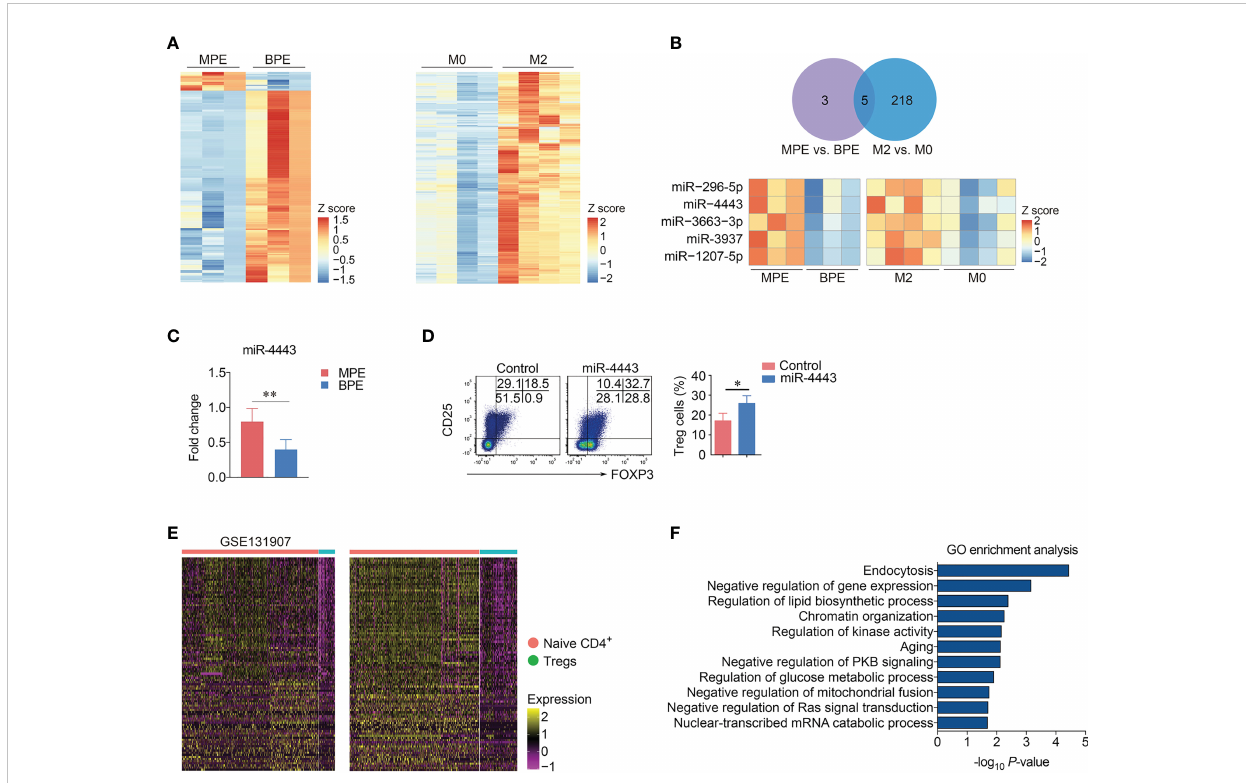
FIGURE 5 miR-4443 induced the differentiation of Treg cells. (A) Heatmaps showed the miRNA expression pro fi le of the exosomes from M j s in MPE and benign pleural effusion (BPE) (each n = 3) (left panel) or in M0 and M2 M j s downloaded from GSE97467. (B) miR-296-5p, miR-4443, miR-3663-3p, miR-3937 and miR-1207-5p were up-regulation in both two data sets. (C) Expression of miR-4443 in the exosomes from MPE and BPE detected by RT-qPCR (each n = 8). Data are presented as mean ± SEM. Comparisons were made using Student ’ s t test. ** P < 0.01, NS, not signi fi cant. (D) Naïve CD4 + T cells were transfected with miR-4443 mimic and negative control under Treg condition (IL-2 and TGF- b ) for 3 days. Representative fl ow cytometry plots of Treg cells (left panel) are displayed from four independent experiments. Comparison of percentages of Treg cells (right panel) is shown. Data are presented as mean ± SEM. Comparisons were made using Student ’ s t test. * P < 0.05. (E) The expression of target genes of miR- 4443 in Naive CD4 + T cells and Treg cells. (F) GO enrichment analysis of the target genes of